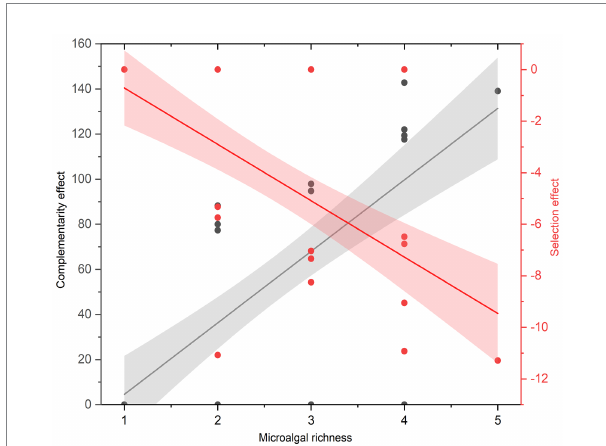
FIGURE 2 The relationships between microalgal richness, the complementarity effect and the selection effect.